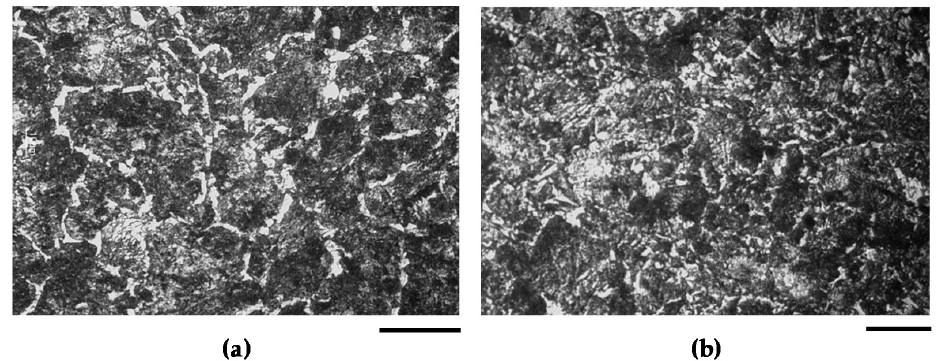
Figure 9. Microstructure of the axle area of the S48C steel grade after heat-treating the hot-forged ( a ) and NSF ( b ) components. Scale bar: ( a ) 30 µ m and ( b ) 100 µ m. Table 10. Average mechanical properties of hot-forged (HF) and NSF components after the same heat treatment.